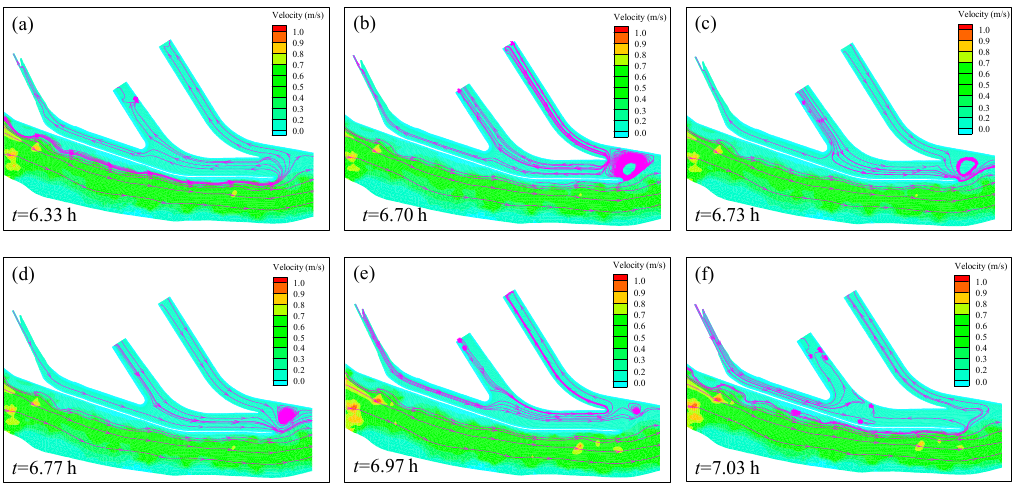
Figure 15. The typical streamline and velocity in multi-approach channels under single-peak regulation of hydropower stations. ( a ) t = 6.33 h; ( b ) t = 6.70 h; ( c ) t = 6.73 h; ( d ) t = 6.77 h; ( e ) t = 6.97 h; ( f ) t = 7.03 h.